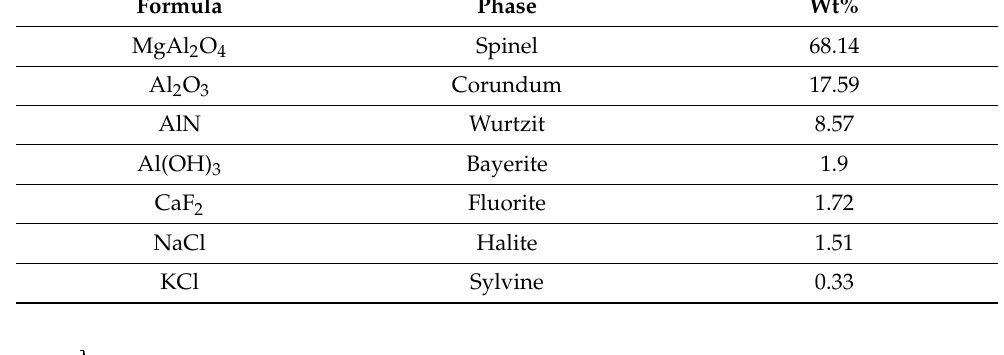
Table 4. Mineral composition of the dross (XRD analysis).